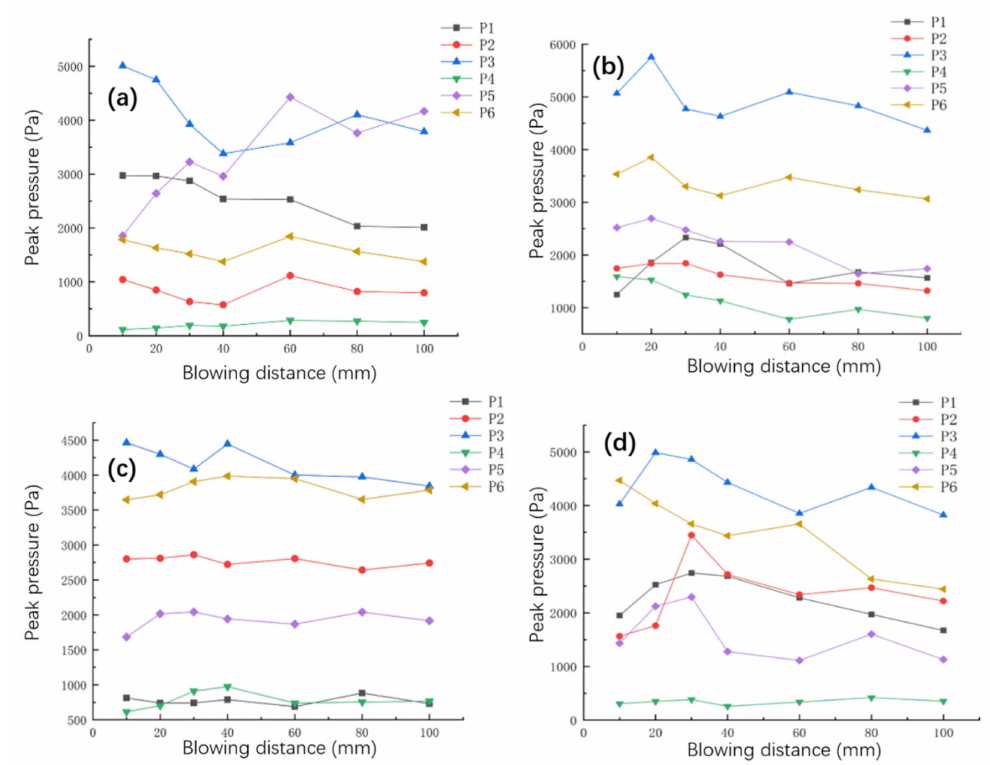
Figure 4. Influence of blowing distance and length of slotted blow hole under blow pressure 0.3 MPa on peak pressure: ( a ) two slotted blow holes, ( b ) three slotted blow holes, ( c ) four slotted blow holes, and ( d ) five slotted blow